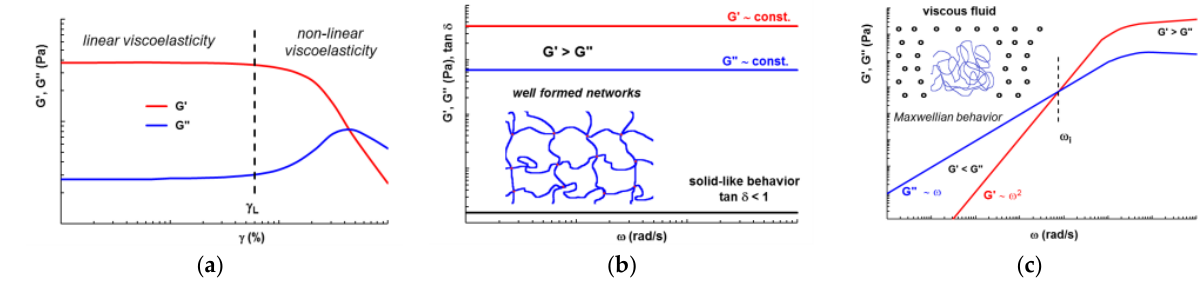
Figure 5. Typical curves showing the evolution of the viscoelastic parameters for gels during an amplitude sweep test ( a ) or frequency sweep test ( b ); typical curves for viscous fluids (uncrosslinked system) ( c ). Weak physical or chemical networks, as well as self-assembling fluids, present intermediate behaviors between the gels ( b ) and viscous fluids ( c ).